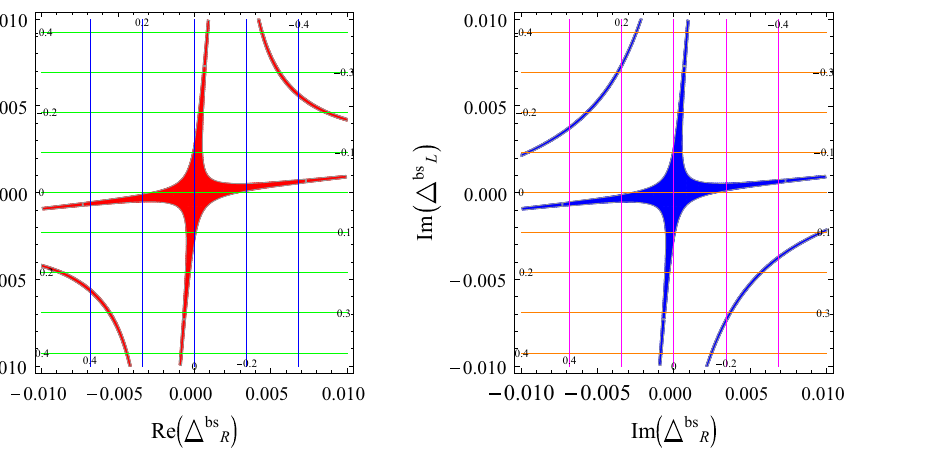
in the LRS corresponding 9 ) = Re ((cid:5) sb ) = 0. In both plots the shaded colored R L for M Z (cid:3) = 1TeV s